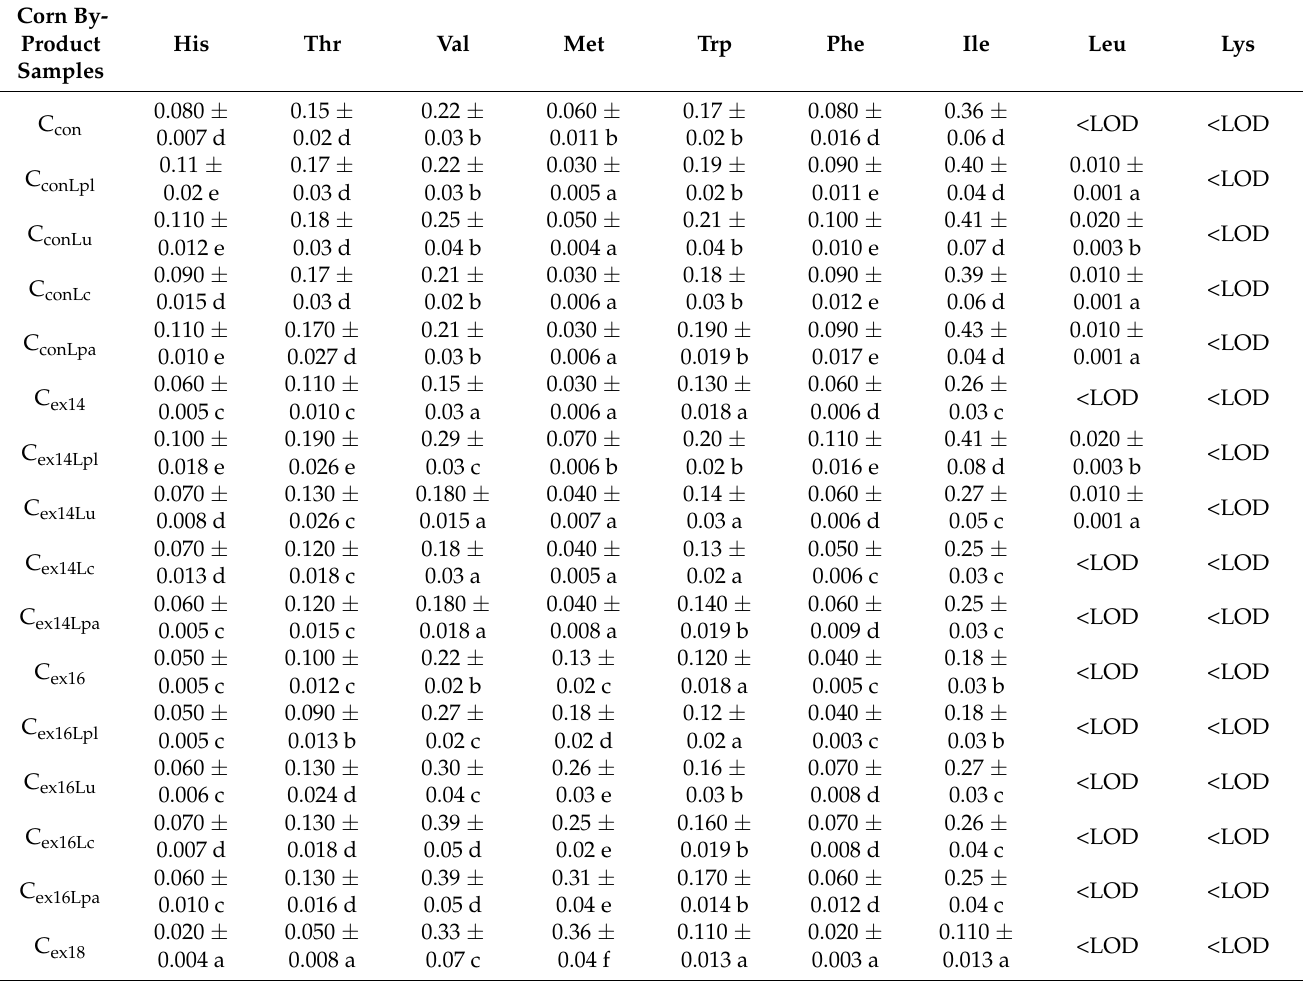
Table 3. Essential amino acids mass concentration (g/100 g) in corn